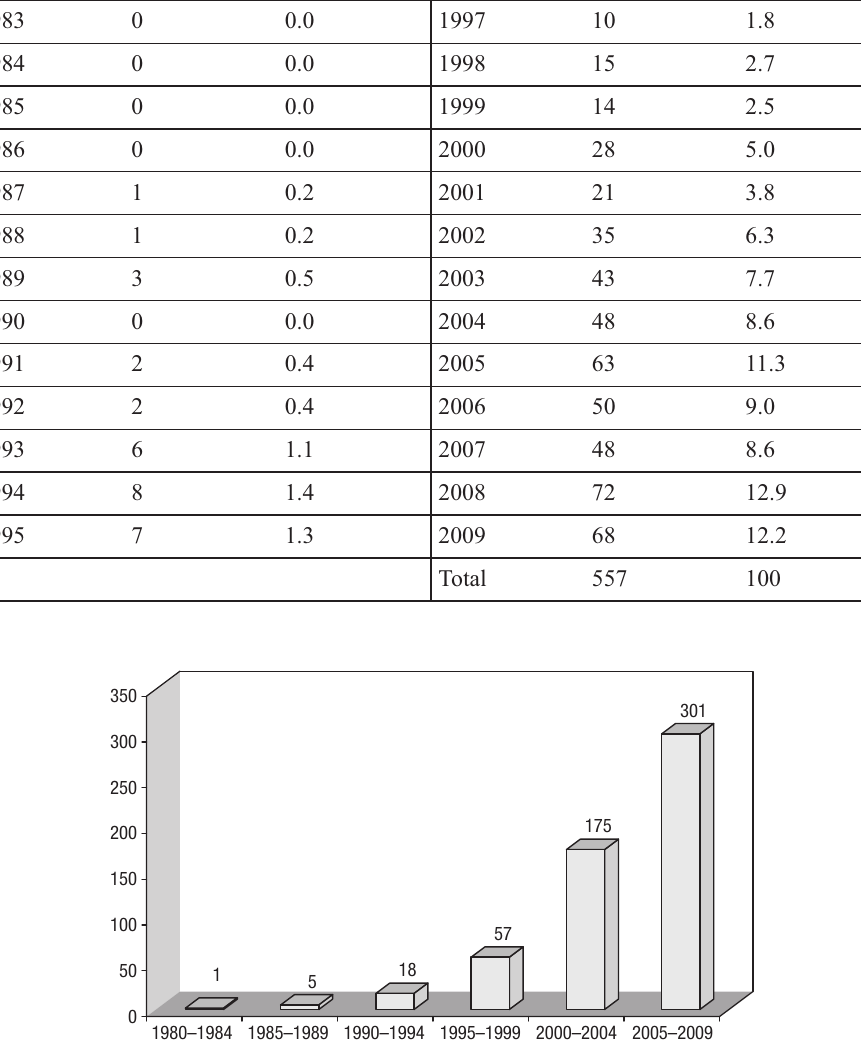
Fig. 2. Number of papers on